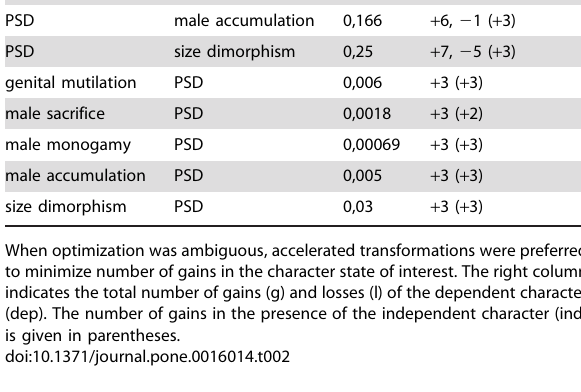
p-value g, l of dep. (g